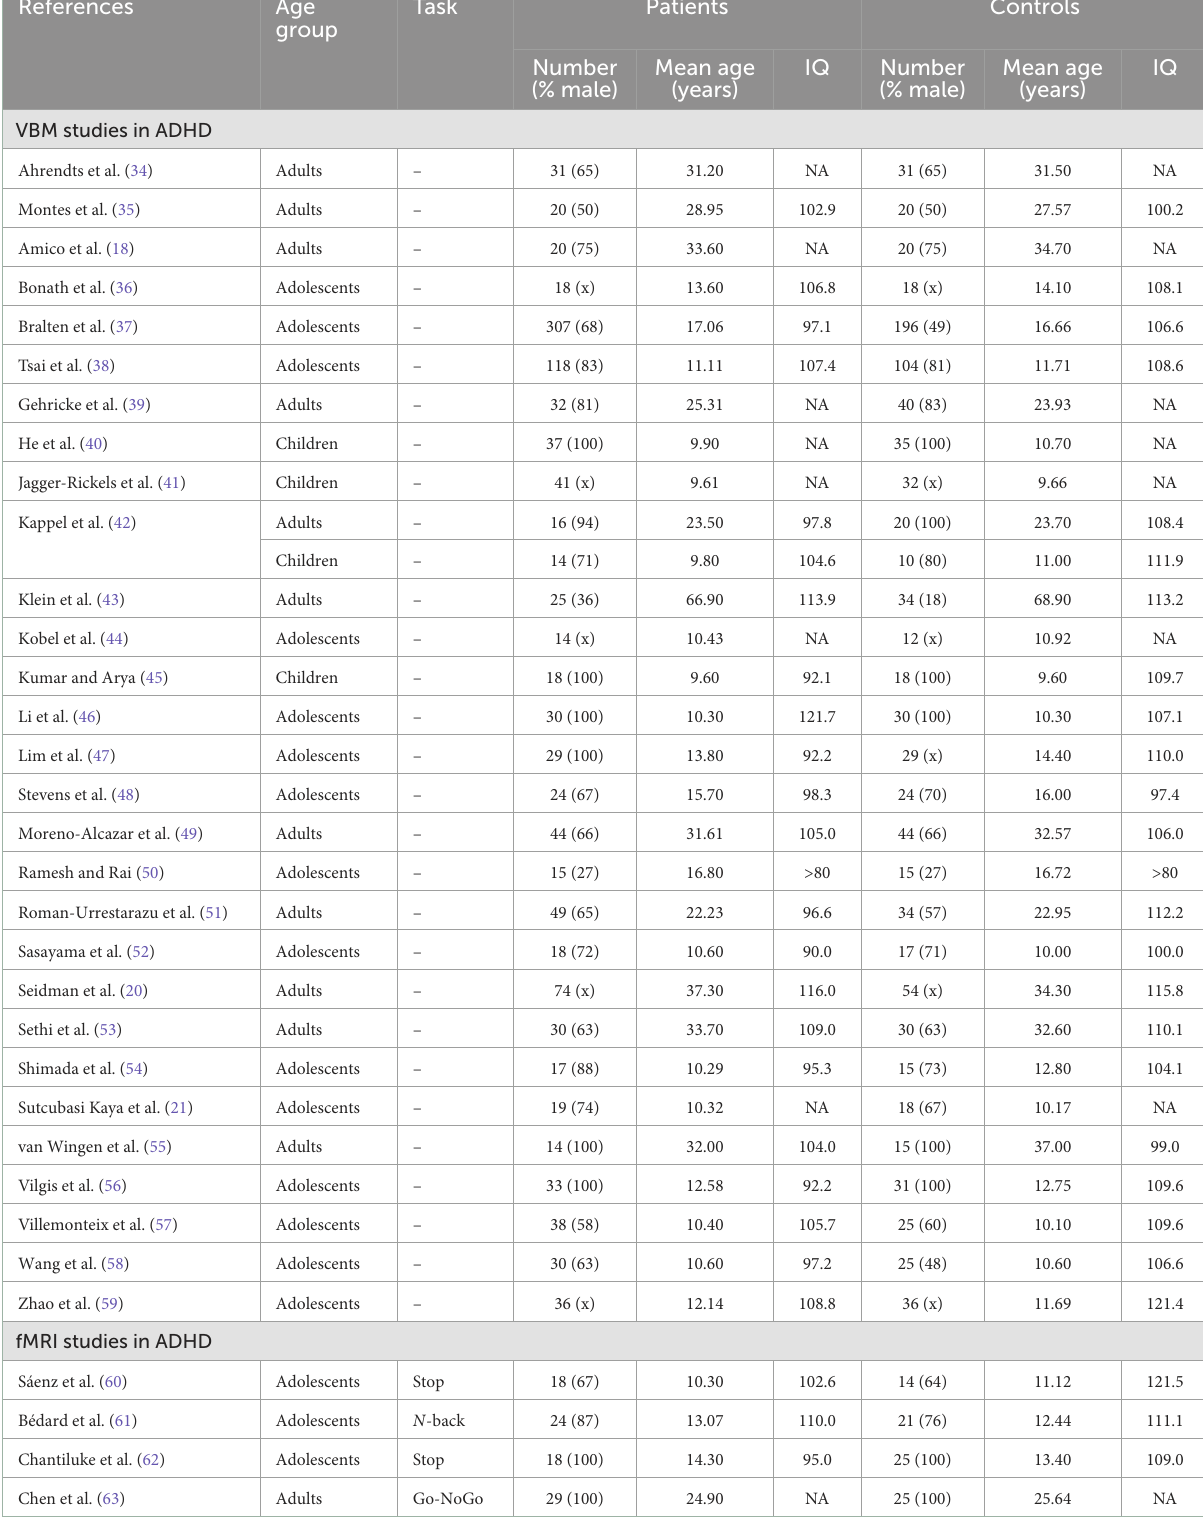
TABLE 1 Sample characteristics of VBM and fMRI